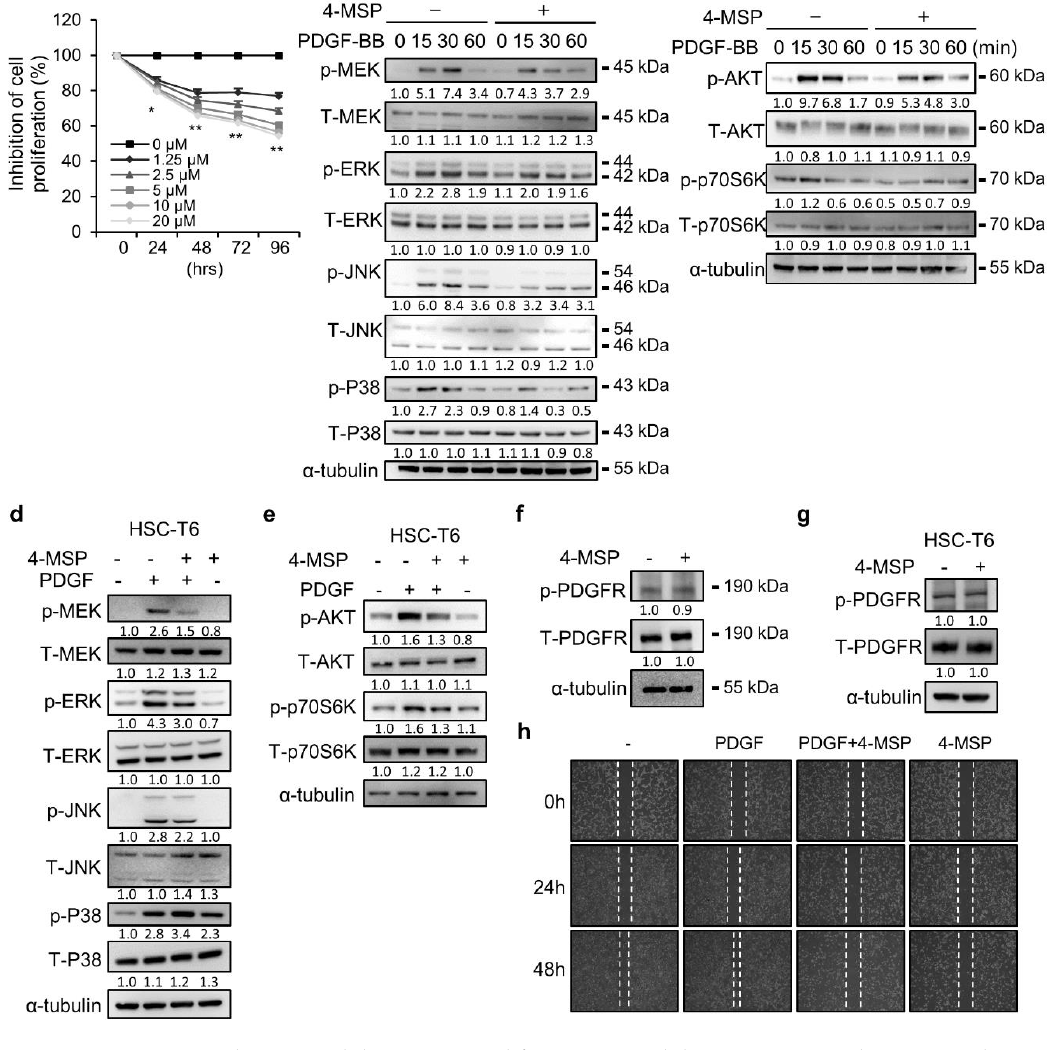
Figure 2. Compound 4-MSP inhibits HSCs proliferation via inhibiting MAPK and AKT signaling pathways. ( a ) LX2 cells in the treatment of 4-MSP at 1.25~20 μM for indicated times , and then